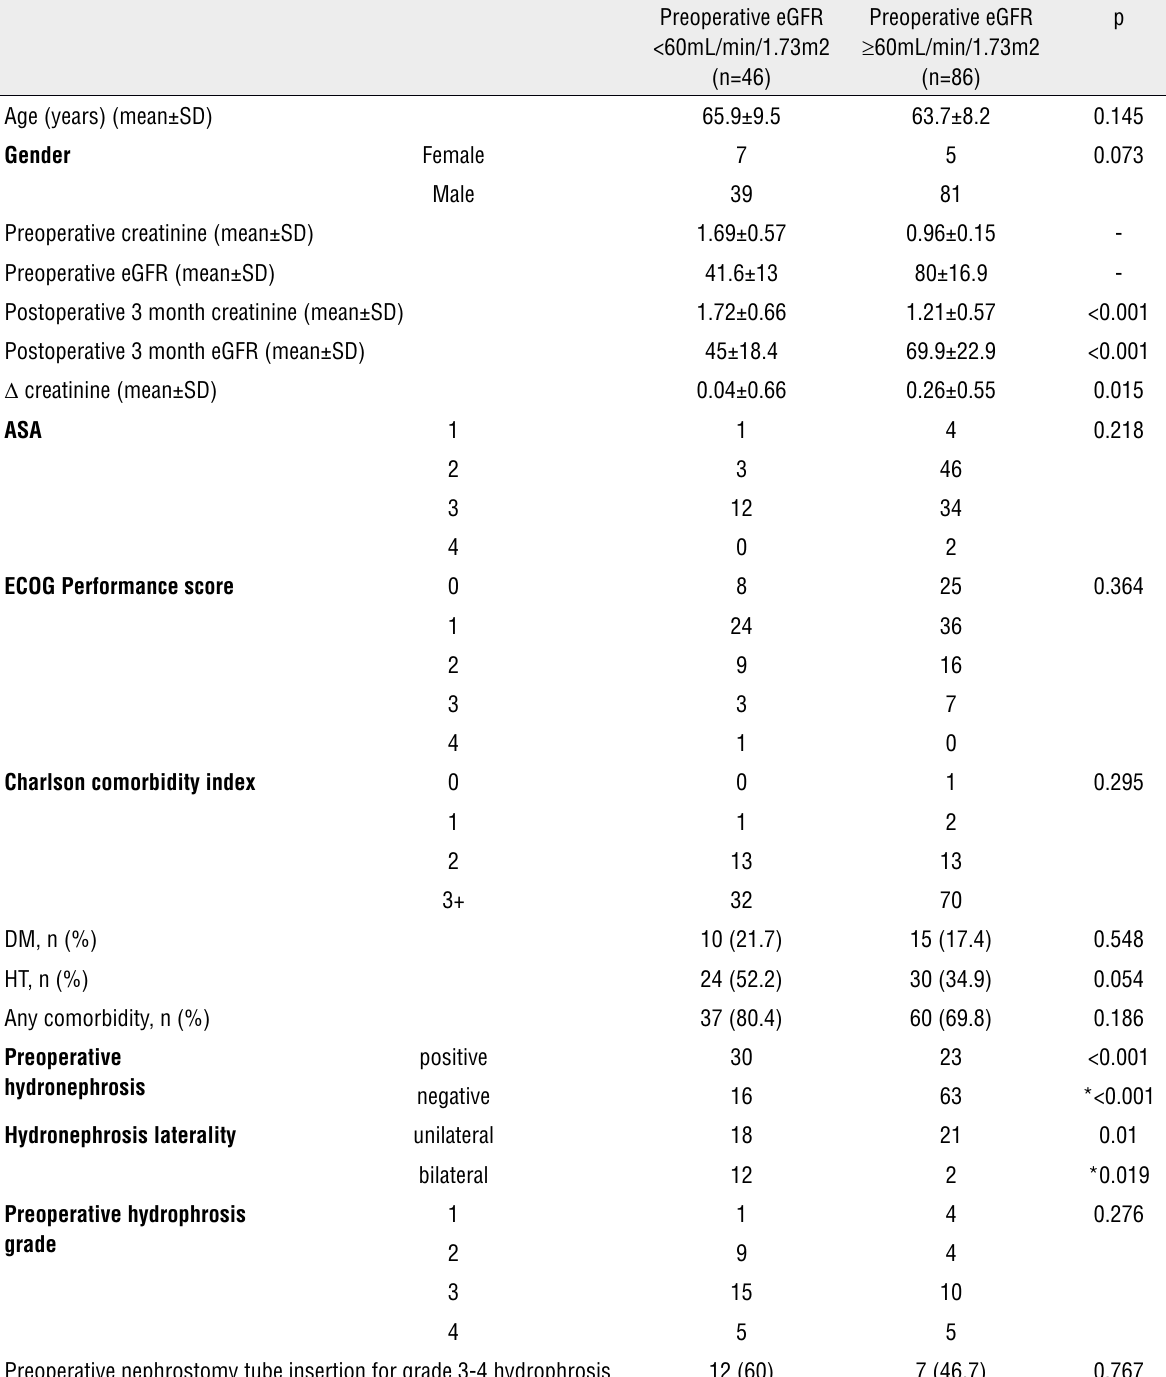
Table 1 - Comparison of patient’s characteristics and preoperative findings between eGFR <60mL/min/1.73m2 and eGFR ≥ 60mL/min/1.73m2 groups according to preoperative eGFR